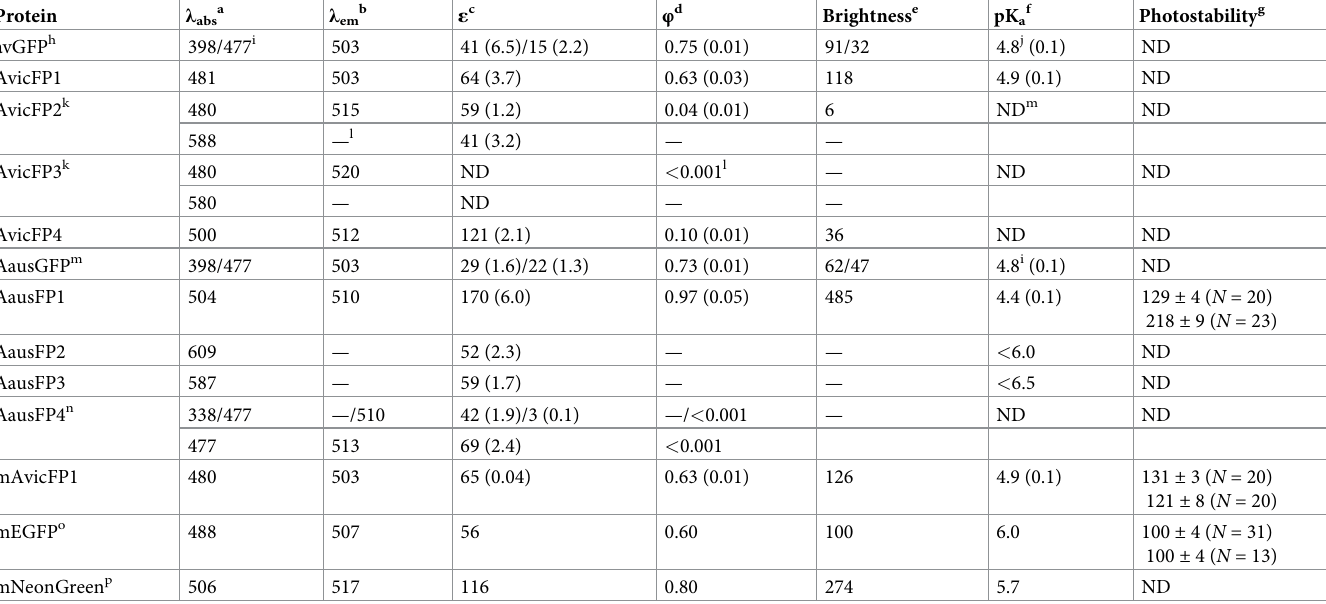
Table 1. Photophysical properties of fluorescent proteins described in this study derived from A . victoria and A . cf. australis . Protein